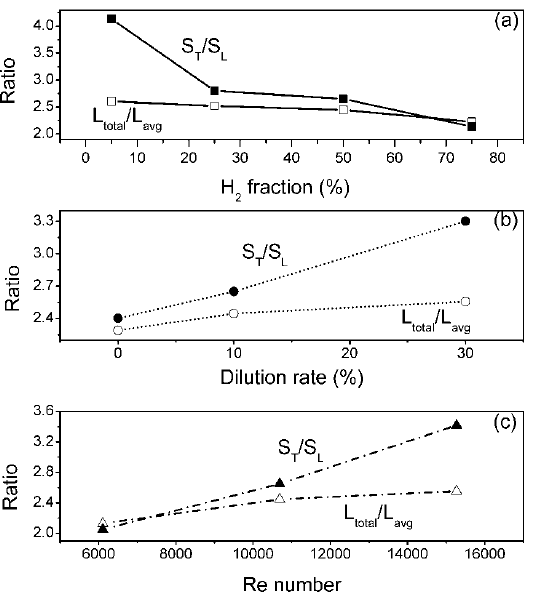
Figure 18. Relationship between the winkled rate and the ratio of turbulent flame velocity to laminar flame velocity under different flame conditions: ( a ) nitrogen dilution volumetric proportion of 10%, Re = 10,690, different hydrogen proportion in fuel; ( b ) hydrogen volumetric rate of 50%, Re = 10,690, different nitrogen dilution; ( c ) nitrogen dilution volumetric proportion of 10%, hydrogen volumetric ratio of 50%, different Reynolds number.